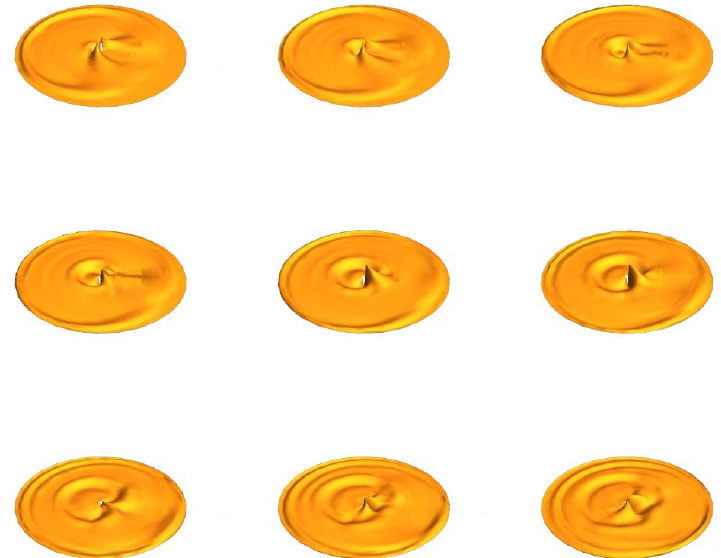
Figure 3. Simulation of the wave propagation for the boundary-value problem posed in Figure 2 implemented in M ATHEMATICA . The numerical results are obtained by carrying out a finite element analysis (FEA). The nine snapshots are taken at t = 9 graphical animation is available at [https://drive.google.com/file/d/1bR06XZAMxqz5sh4o1BKi2 WRTHPUwsxNC/view?usp=sharing]. Accessed date is 28 July